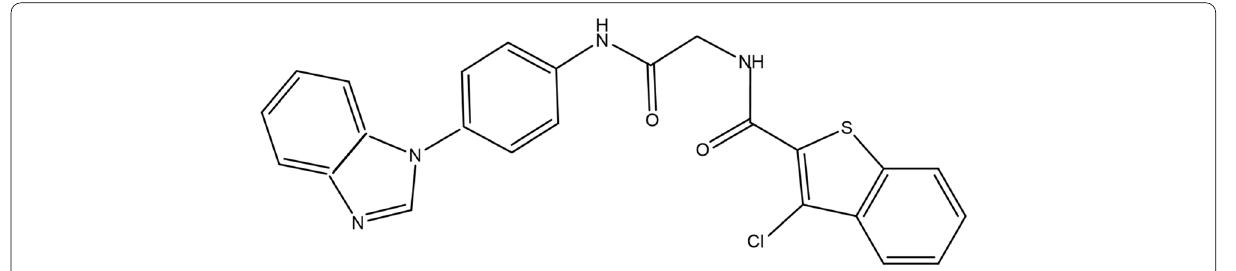
Fig. 1 Structure of C 24 H 17 ClN 4 O 2 S compound